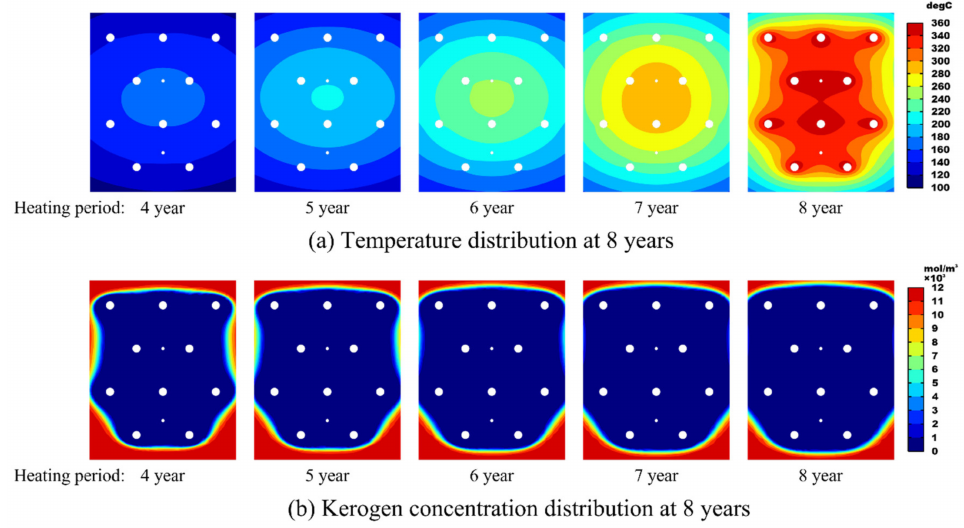
Figure 11. Effect of the heating period on: ( a ) temperature distribution; ( b ) kerogen concentration